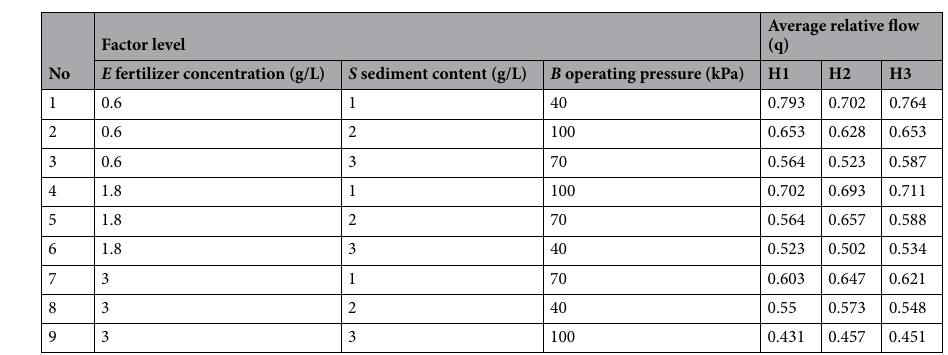
Table 3. Results of uniform orthogonal tests.